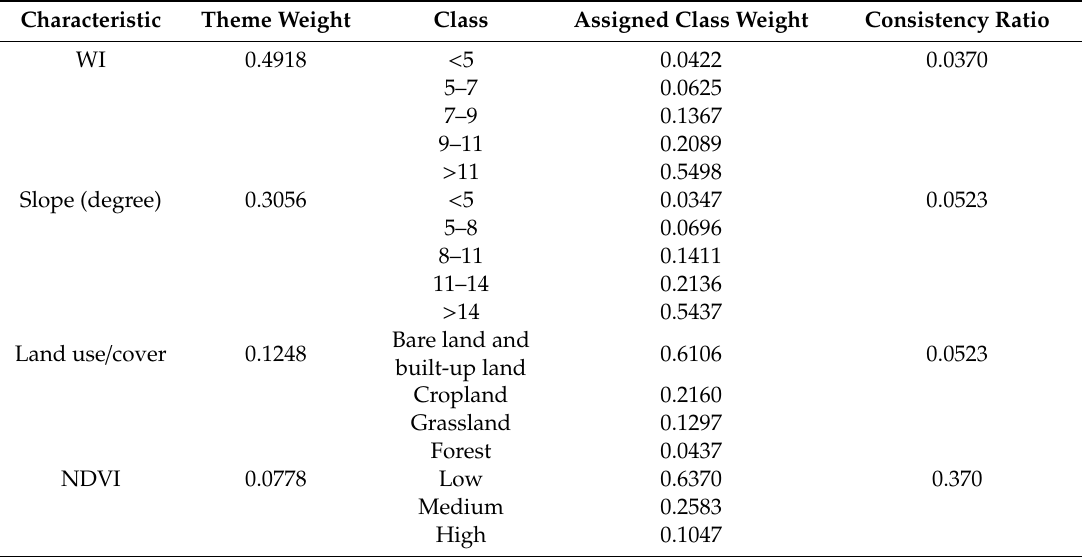
Table 2. Weight of each factor on runo ff potential.